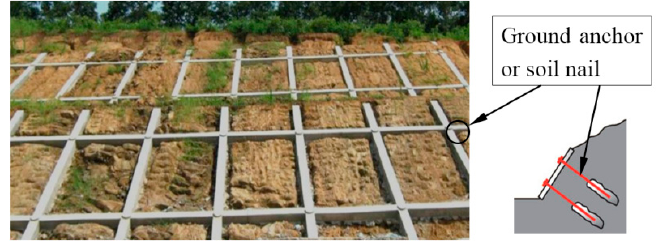
Figure 1. A typical application of grid beam structure on man-made slope.